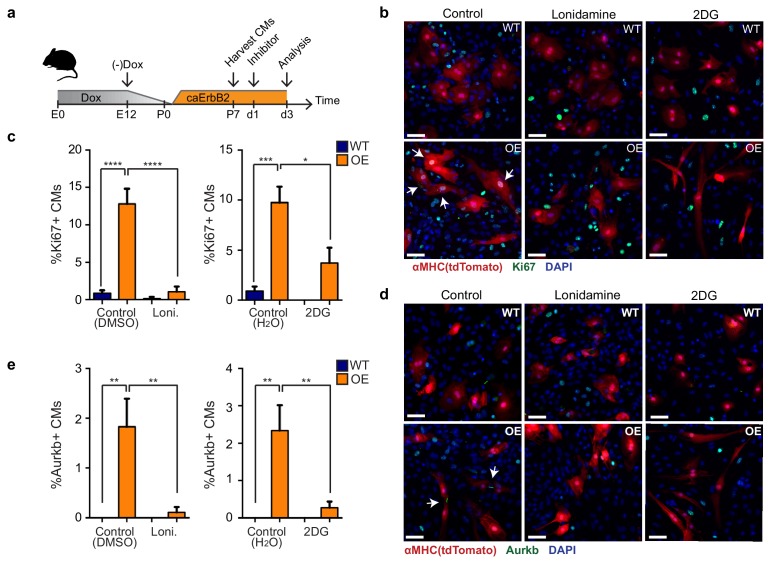
Glycolysis inhibitors impair mitogenic effect of ErbB2 activation in cardiomyocytes.(a) Cartoon showing the experimental procedure to analyse the effects of glycolysis inhibitors (2-DG and lonidamine) on cardiomyocyte proliferation. (b) Immunofluorescence analysis on P7 cardiac cultures derived from WT and caErbB2 OE hearts that are endogenously fluorescent for tdTomato under the MYH6 promoter, stained for the cell-cycle marker Ki67. Arrows point at Ki67+ CMs. (c) Quantification of % Ki67+ CMs from WT and caErbB2 OE derived from P7 cardiac cultures treated with the glycolysis inhibitors 2-DG (n = 4 for WT and n = 4 for OE), and lonidamine (n = 7 for WT and n = 4 for OE) or their diluents as controls. (d) Immunofluorescence analysis on P7 cardiac cultures derived from WT and caErbB2 OE hearts that are endogenously fluorescent for tdTomato under the MYH6 promoter, stained for the cytokinesis marker Aurora kinase B. Arrows point at Aurkb+ CMs. (e) Quantification of % Aurkb+ CMs from WT and caErbB2 OE derived from P7 cardiac cultures treated with the glycolysis inhibitors 2-DG (n = 4 for WT and n = 4 for OE), and lonidamine (n = 7 for WT and n = 4 for OE) or their diluents as controls. In all panels, bars represent the mean, and error bars represent s.e.m *p<0.05, **p<0.01, ***p<0.001, ****p<0.0001, Scale bars represent 50 μm.